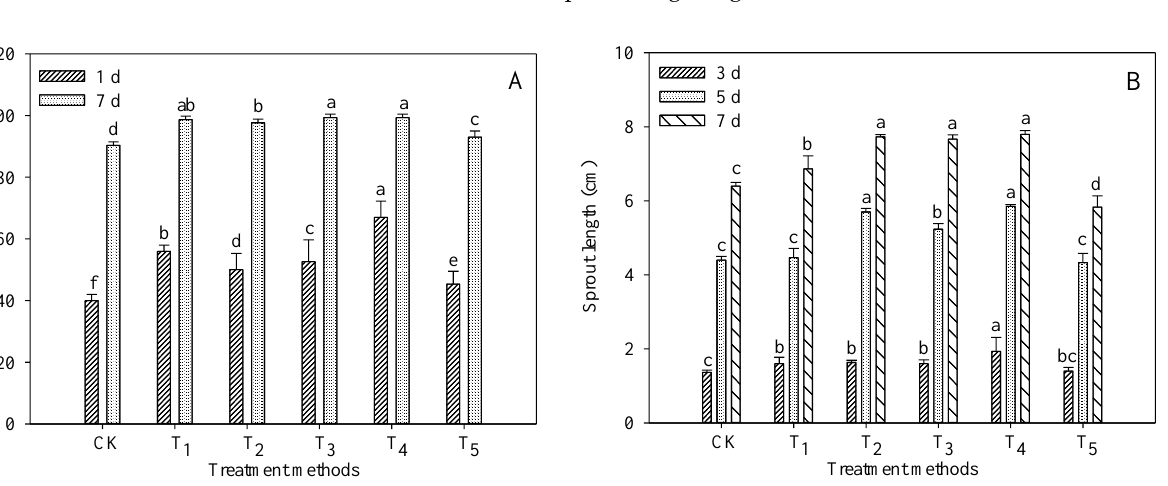
Figure 1. Effect of exogenous additives on the growth of TB sprouts. ( A ) Germination rate (%); ( B ) Sprout length (cm). Different lowercase letters indicate significant statistical difference ( p < 0.05).